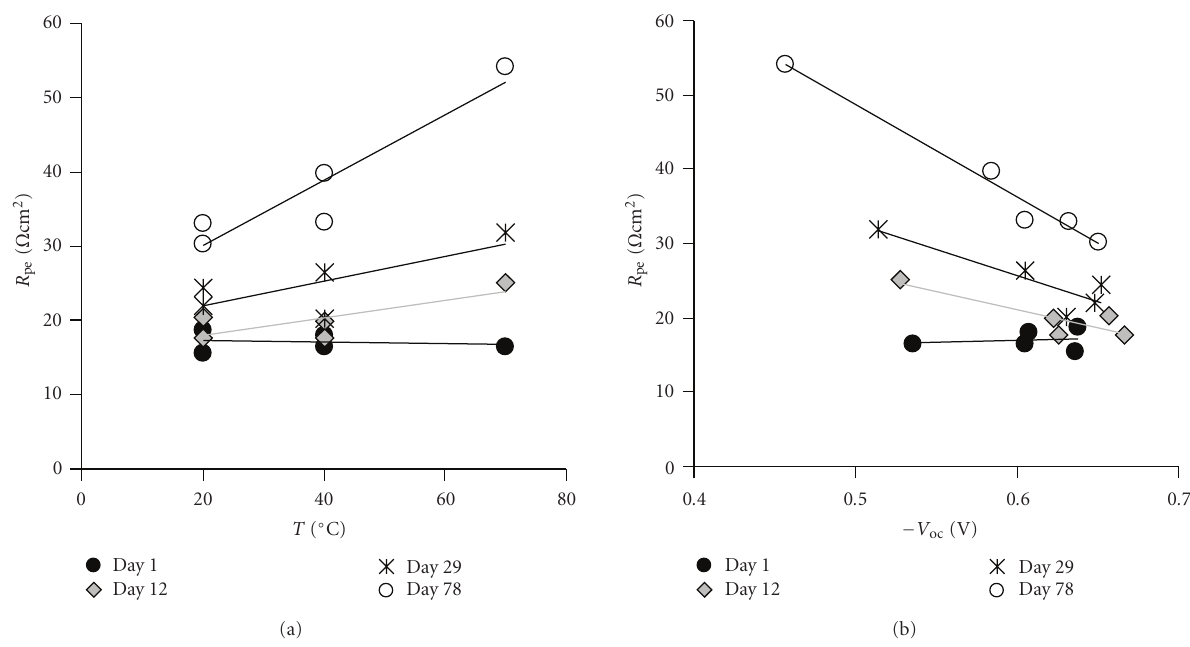
Figure 6: Photoelectrode (total) resistance as a function of temperature (a) and open circuit voltage (b) on di ff erent measurement days; first set of EIS